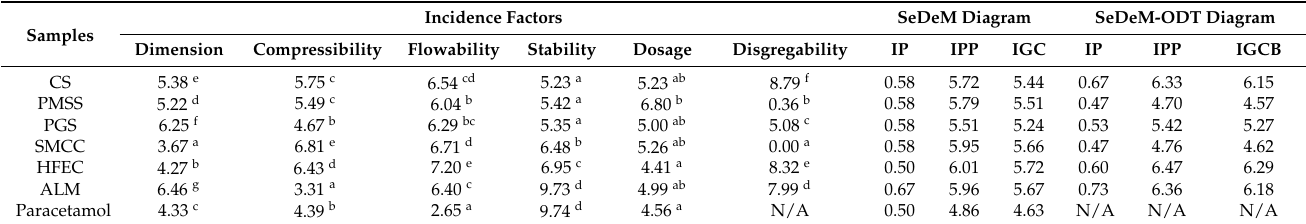
Table 2. Incidence factor and parametric index values of paracetamol and